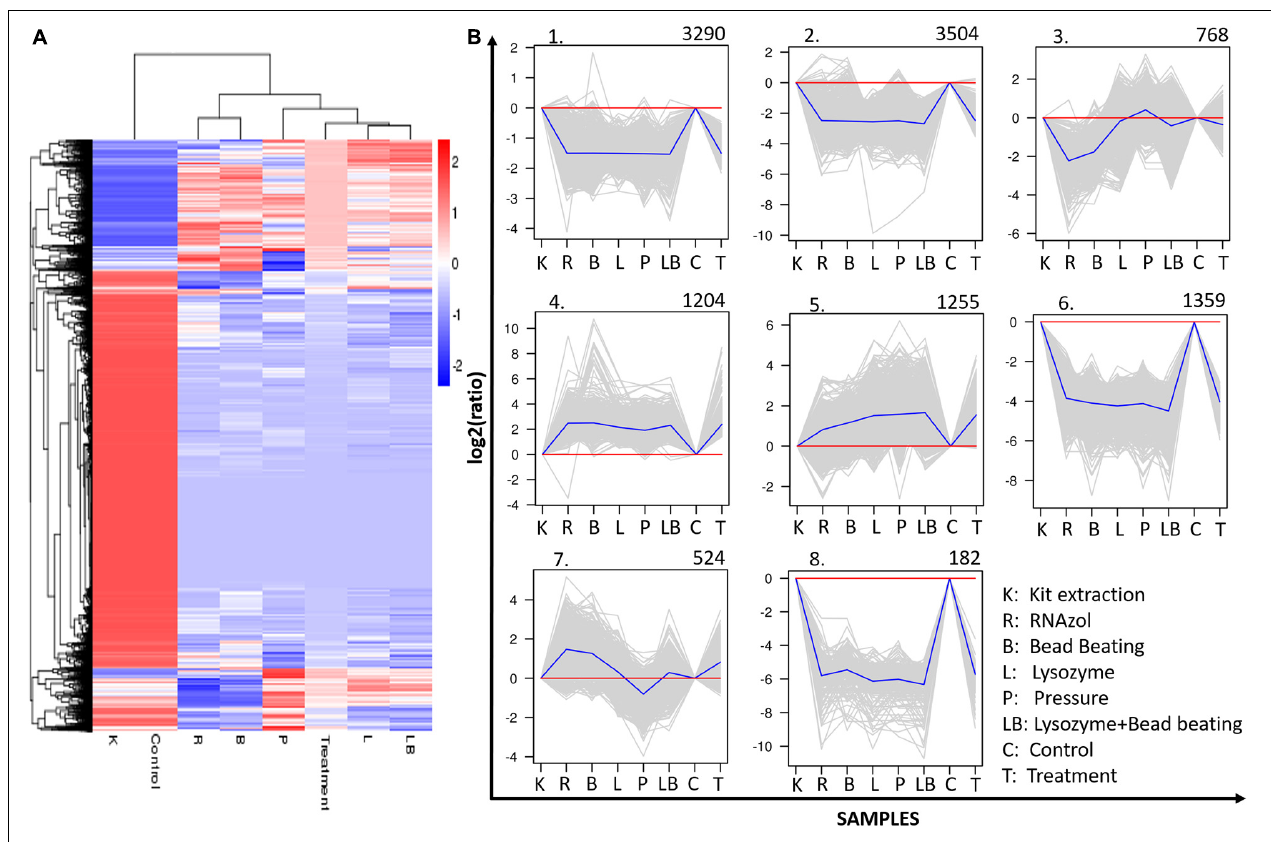
FIGURE 6 | Clustering analysis of differentially expressed genes (DEGs). (A) Hierarchical clustering graph of the 12086 DEGs based on the average log 10 (FPKM + 1) values of all genes in each cluster. Red bands indicate higher gene expression, while blue bands indicate lower gene expression. (B) Clustering of the 12086 DEGs into eight subclusters. The number of genes in each cluster is presented at the top of each cluster. Blue lines indicate the average relative expression levels in each subcluster relative to a log2 ratio of 0, which is represented by the red line. Gray lines represent the relative expression levels of each gene in each cluster. The sample names and corrected expression levels are presented on the x axis and y axis,